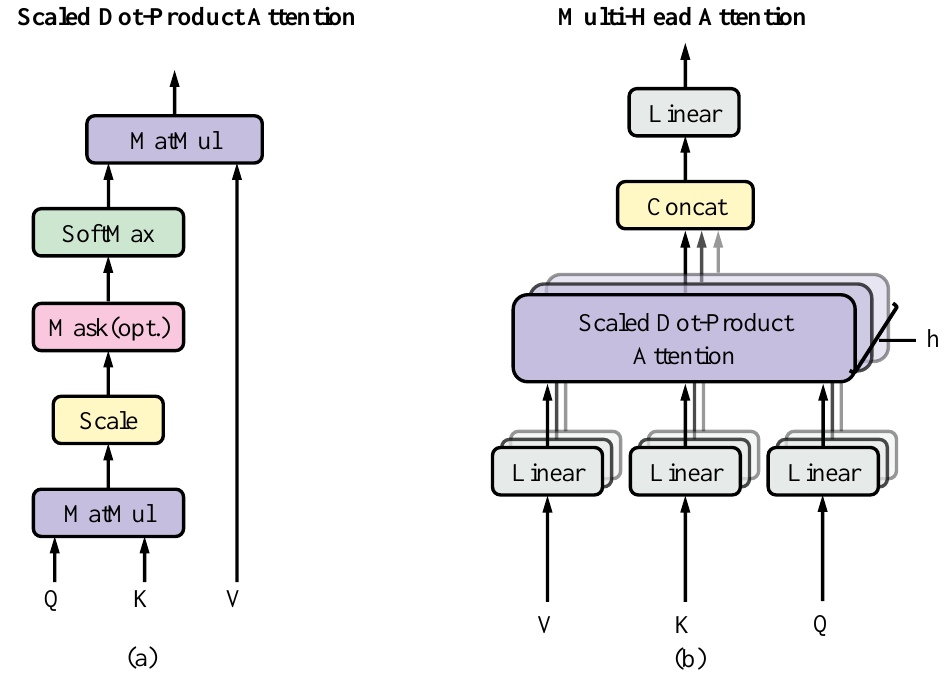
Figure 6. ( a ) Scaled dot–product attention. ( b ) Multi-head attention consists of several attention layers running in